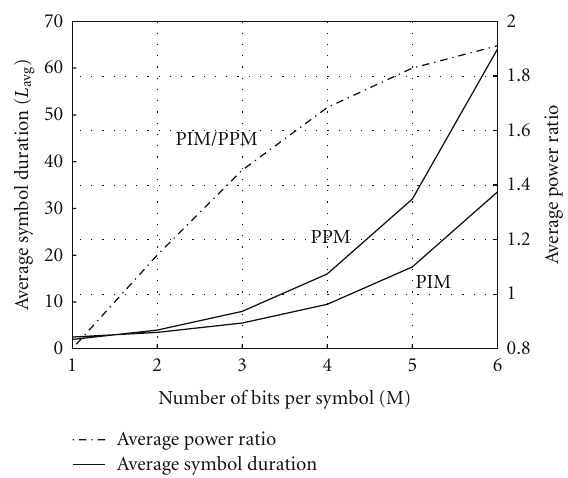
Figure 1: Dependence of symbol duration ( L avg ) and average power ratio (Pow PIM / Pow PPM ) on the number of bits per symbol.